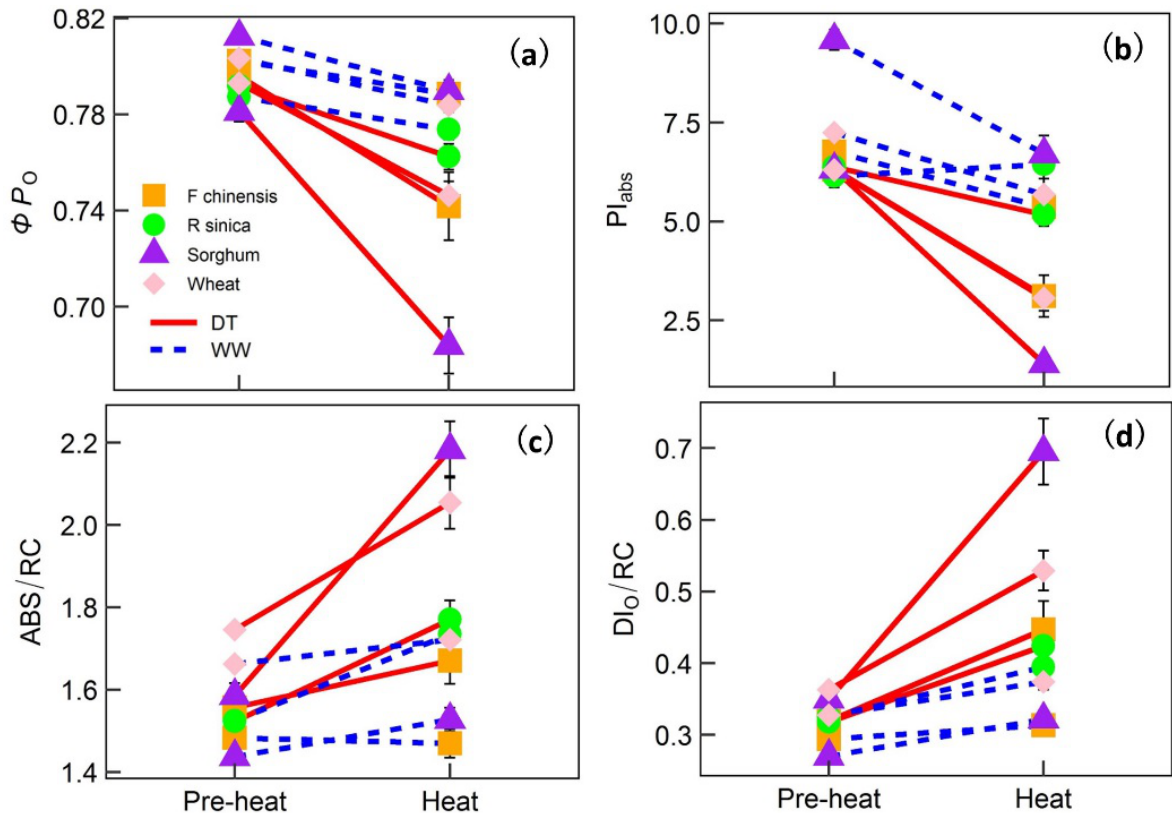
Figure 6. Responses of two downregulated parameters, Φ P O (quantum yield of primary photochemistry (Panel ( a )) and PI abs (performance index on an absorption basis (Panel ( b )), and two upregulated representative OJIP parameters, ABS/RC (absorption flux (Panel ( c )) and DI O /RC (dissipation flux (Panel ( d )) to either heat, drought or their combination in four plant species. The red line connects drought-treated (DT) plants of each species under the pre-heat and heat treatments; the blue dashed line connects well-watered (WW) plants of each species. The corresponding linear mixed analysis of variance results are shown in Table 2. Table 2. Results of linear mixed-effects analysis of variance on the effects of heat stress combined with pre-existing drought.